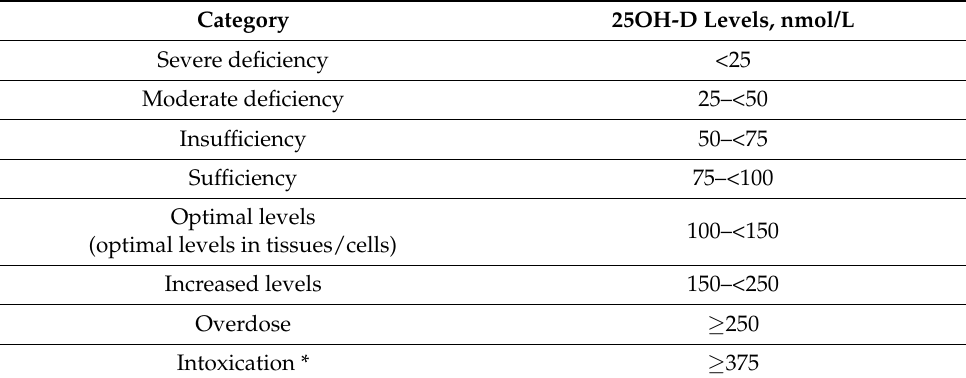
Table 2. Vit. D status categories by 25OH-D